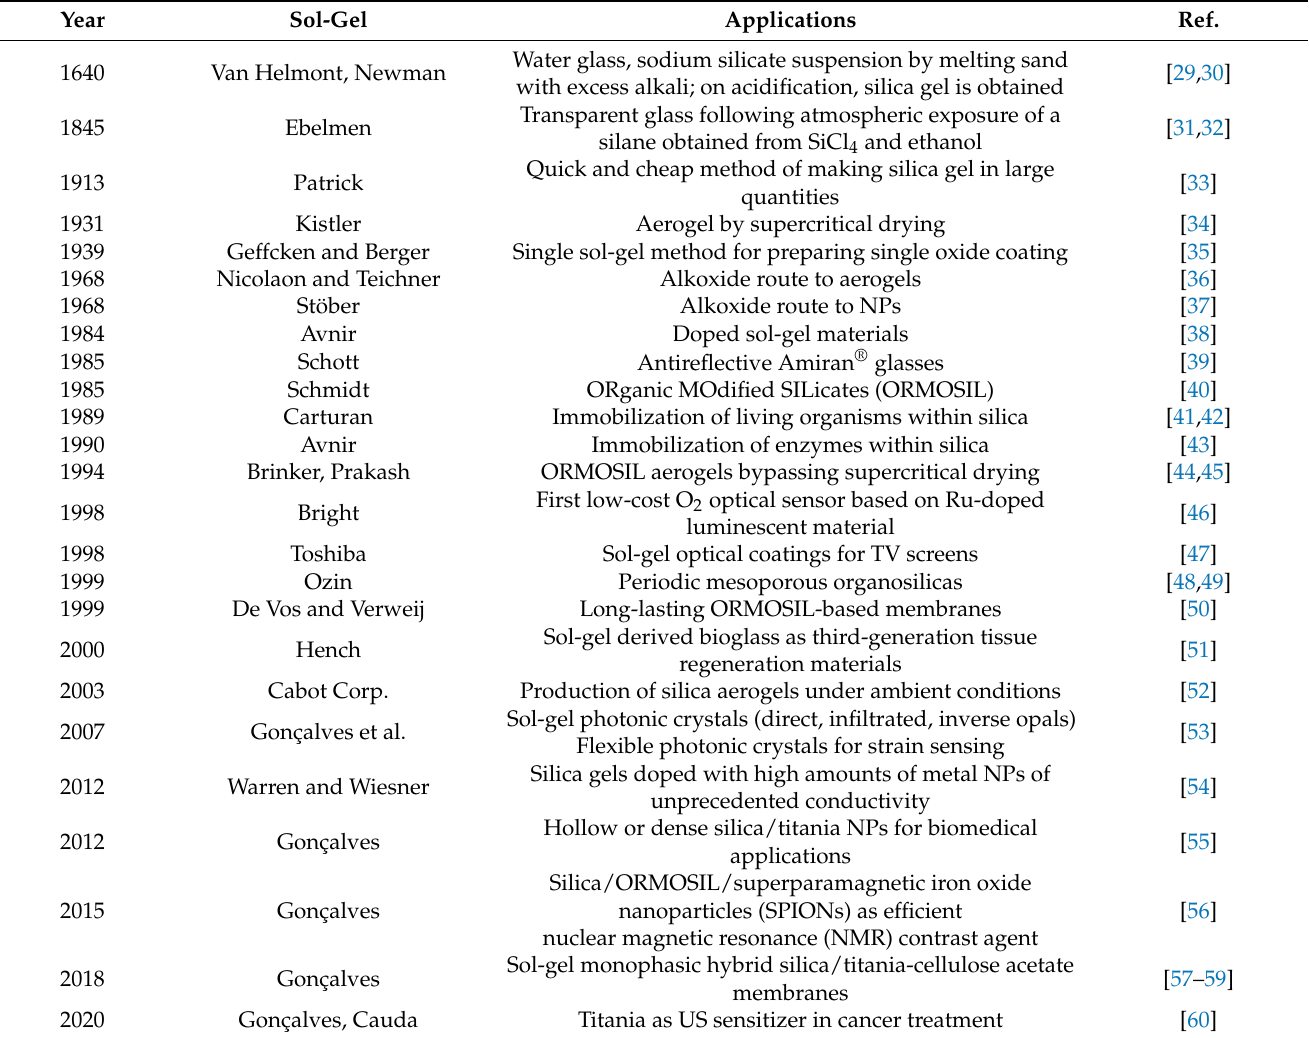
Table 2. Breakthrough in sol-gel glass methodologies adapted from [24] (third generation on glass